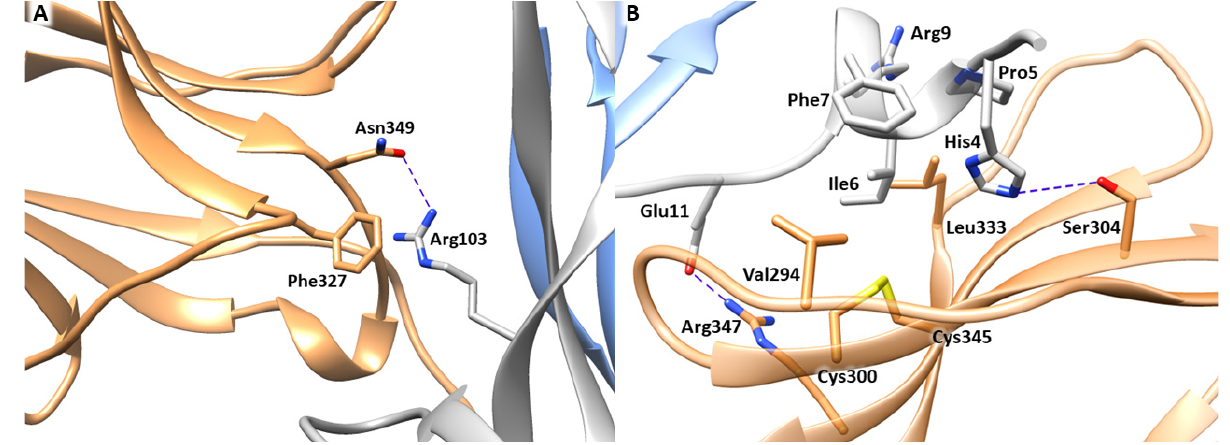
Figure 2. Binding interfaces of NGF-TrkA complex. ( A ) Close view of the conserved patch. ( B ) Close view of the specific patch. The key residues of the two binding interfaces are represented as grey (NGF) and sand-colored (TrkA) sticks. H-bond interactions are depicted as blue dashed lines. The image was created by means of Chimera software.